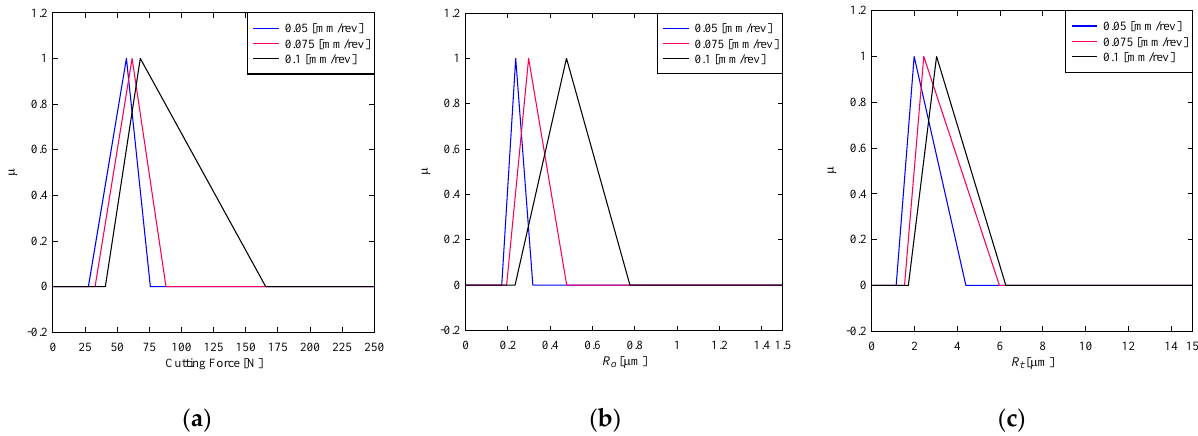
Figure 7. Effect of feed rate on ( a ) cutting force ( b ) R a ( c ) R t .